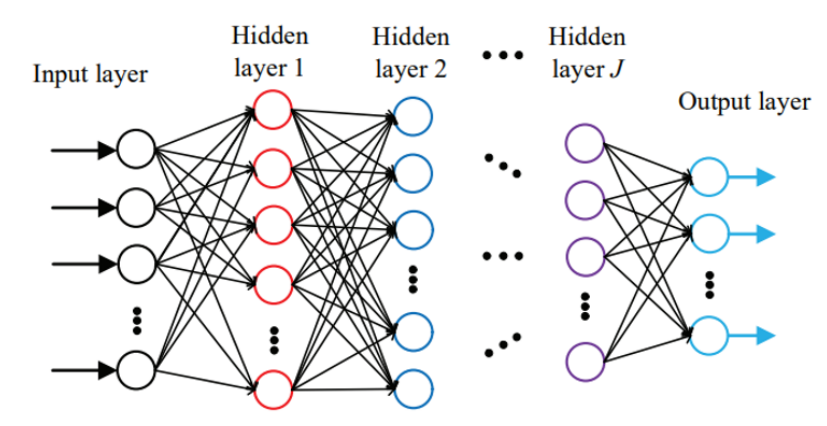
Figure 5. Layered DNN structure.